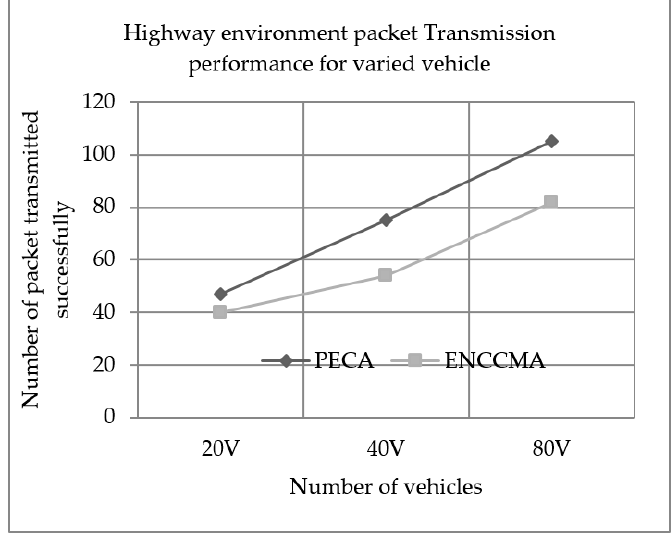
Figure 5. Highway environment packet Transmission performance for varied vehicle.